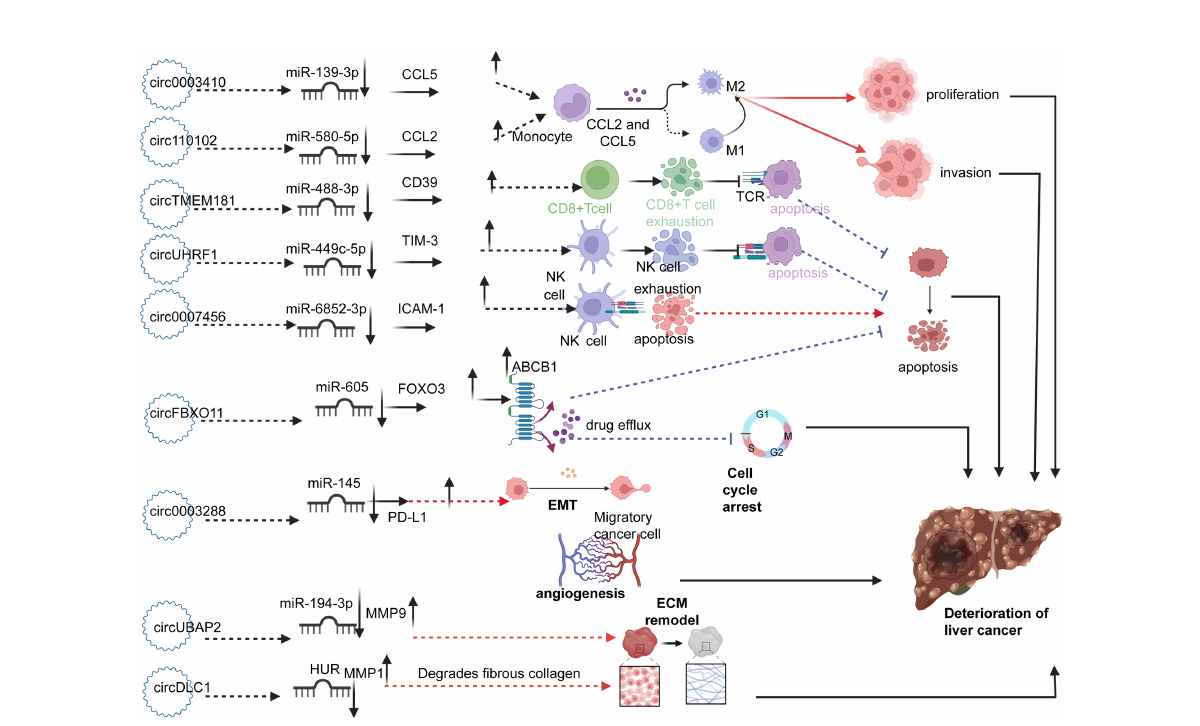
FIGURE 3 Circ0003410 and circ110102 upregulate CCL5 and CCL2 by sponging miR-139-3p and miR-580-5p, respectively, thereby promoting the polarization of M2 macrophages and promoting cell proliferation and invasion. CircTMEM181 and circUHRF1 promote depletion of CD8+T and NK cells through the miR-488-3p/CD39 and miR-499-5p/TIM-3 axis, thus inhibiting apoptosis of cancer cells. Circ0007456 upregulates CAM-1 by sponging miR-6852-3p, which increases the lethality of NK cells to cancer cells and promotes tumor cell apoptosis. CircFBXO11 increases the expression of ABCB1 protein on the surface of cancer cells by upregulating FOXO3 and enhancing drug resistance. Circ0003288 promotes EMT through Mir-145/PDL1. ECM remodeling is mediated by the upregulation of MMP1 and MMP9 by circUBAP2 and circDLC1, thereby promoting metastasis. The role of circRNAs above promotes the occurrence and deterioration of